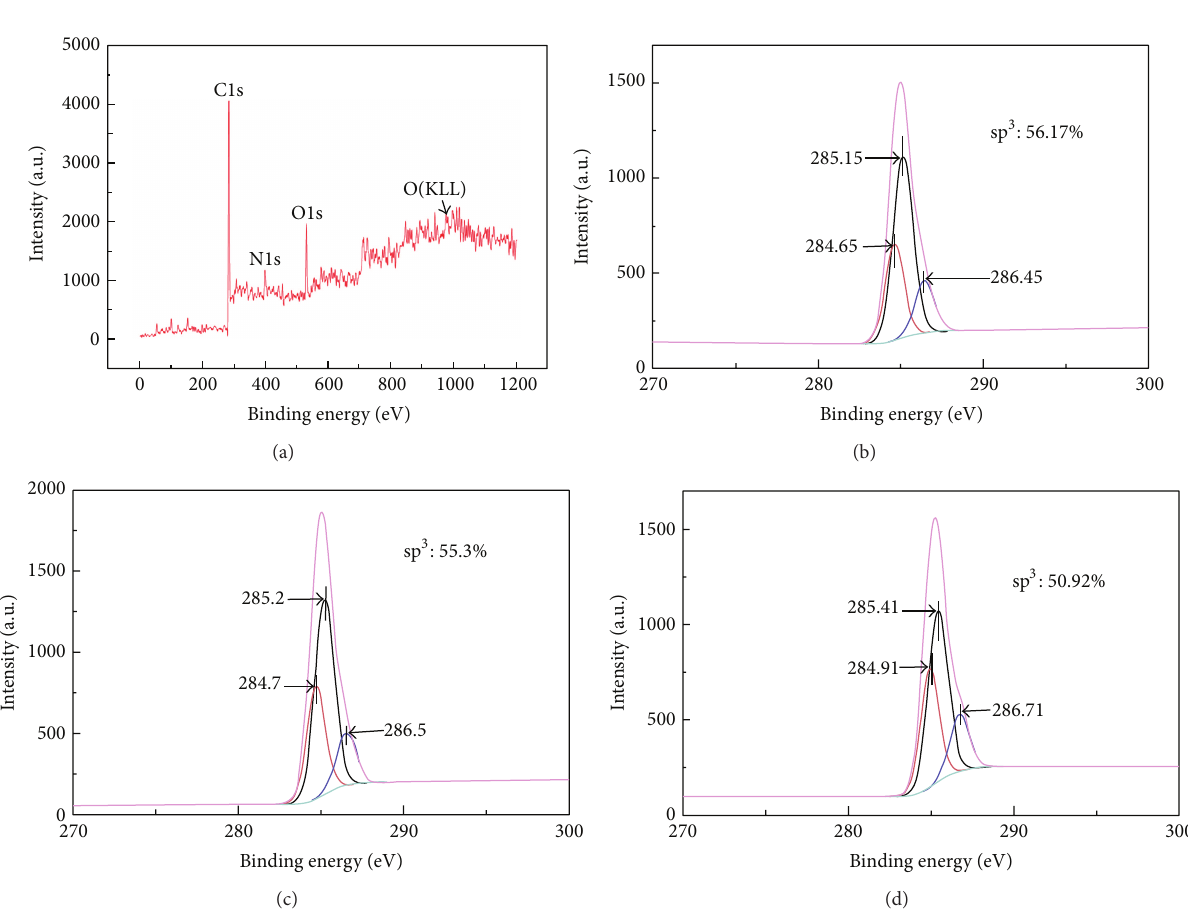
Figure 2: XPS survey spectrum (a) and the deconvolution of the C1s binding energy peak of the XPS spectrum of the DLC films; (b) DLC film (specimen GD 9) deposited under a sputtering power of 200 W, work distance of 10cm, working pressure of 3 mTorr, and deposition time of 0.5h. (c) DLC film (specimen GD 6) deposited under the sputtering power of 175 W, work distance of 10cm, working pressure of 1mTorr, and deposition time of 1h. (d) DLC film (specimen GD 3) deposited under the sputtering power of 150W, work distance of 10cm, working pressure of 5mTorr, and deposition time of